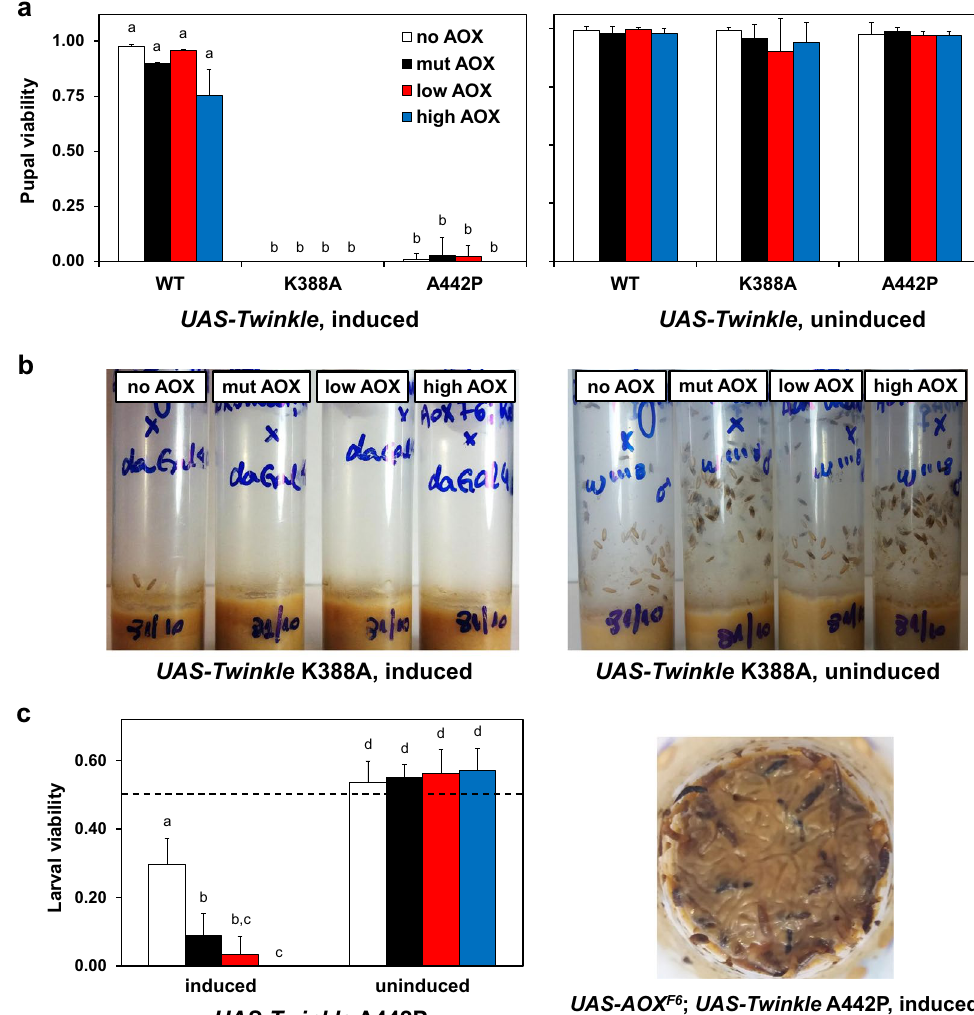
Figure 1. AOX does not rescue the lethality caused by the expression of mutant Twinkle proteins. ( a ) Pupal viability was measured as the mean ratio between the number of adults eclosed and the number of pupae per vial ( + / − standard deviation), upon expression (using the daGAL4 driver, left panel ) or not (using the w 1118 control, right panel ) of the indicated AOX and Twinkle variants. ( b ) A representative developmental assay showing the inability of larvae overexpressing Twinkle K388A to enter the pupal stage: whereas the control adult flies at day 7–9 after egg laying ( right panel ) were starting to eclose, Twinkle K388A flies were still alive as active larvae on the food, with very few individuals reaching pre-pupa and dying. ( c ) Larval viability of the UAS-Twinkle A442P lines was measured as the mean ratio between the number of wild-type pupae and the total number of pupae per vial ( + / − standard deviation), originated from crosses using UAS-Twinkle A442P / TM6B- Tubby and daGAL4 (induced) or w 1118 (uninduced). The expected Mendelian ratio of wild-type pupae (carrying UAS-Twinkle A442P ) for these crosses is 0.5 (dashed line). See Supplementary Fig. S1 for details of the genetic crosses. no AOX, mut AOX, low AOX and high AOX indicate respectively the constructs UAS-empty 2nd , UAS- mutAOX 2nd , UAS-wtAOX 8 . 1 21 and UAS-wtAOX F6 12 . Letters a-d indicate significantly different statistical classes ( P < 0.05) according to one-way ANOVA, followed by the Tukey post-hoc test, applied separately for the data in ( a ) left panel , and ( c ). No significant differences were found ( P > 0.05) for the data shown in ( a ) right panel